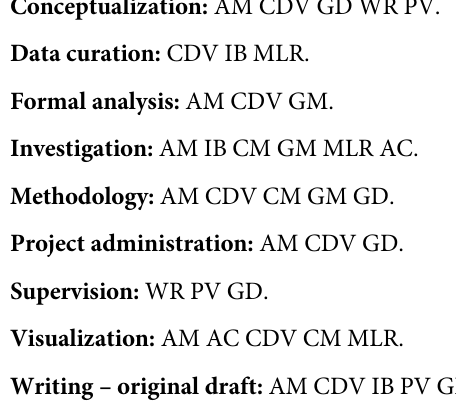
S1 Table. Summary characteristics of participants and interventions of included studies. S2 Table. Methodological quality